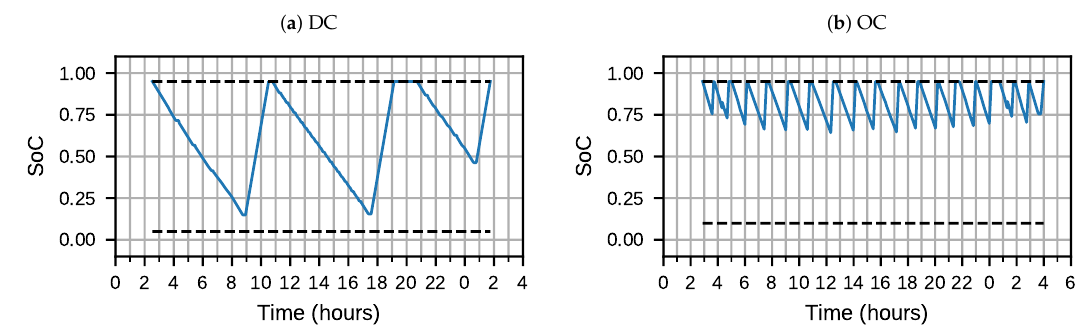
Figure 11. Typical vehicle SOC time series from schedule simulation.